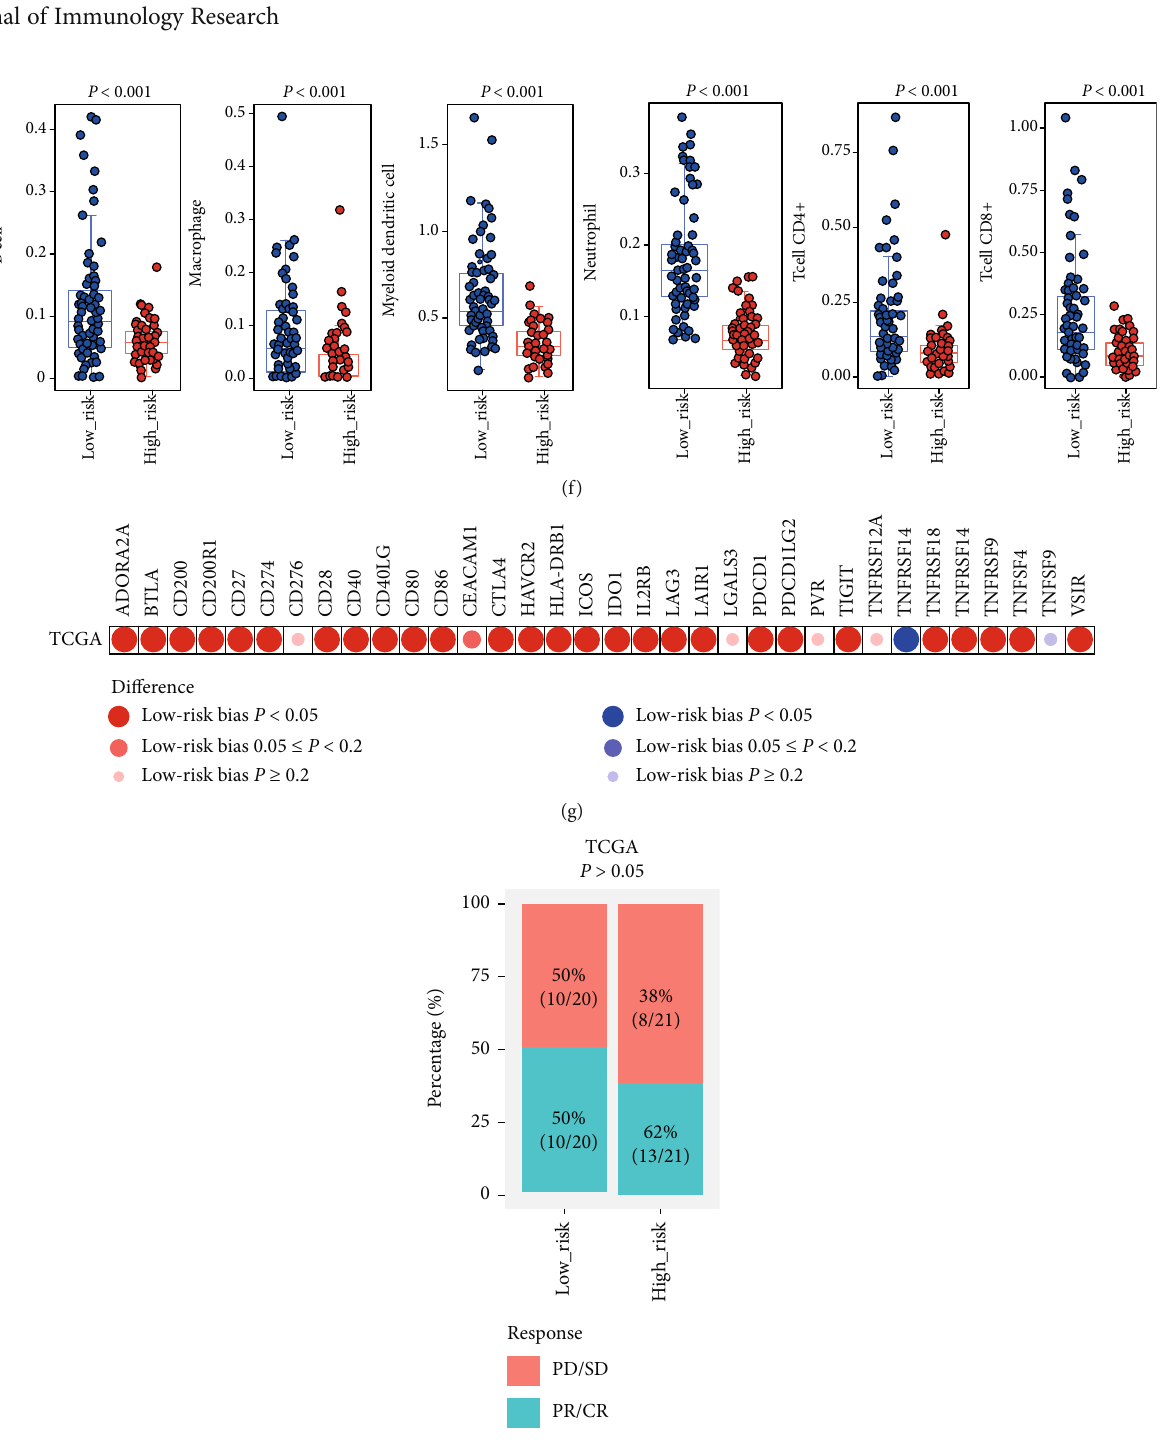
Figure 5: The relationship between the IAG signature and immunotherapy-related biomarkers. (a) The propensity score between the high- risk and low-risk groups. (b) CYT, (c) GEP, (d) BCR richness, and (e) TCR richness. (f) Six immune cell populations, including B cell, macrophage, myeloid dendritic cell, neutrophil, T cell CD4+, and T cell CD8+ between the high- and low-risk groups. (g) Di ff erences in the mRNA expression level of 34 immune checkpoints. (h) Comparison of immunotherapy response rate between the high- and low-risk